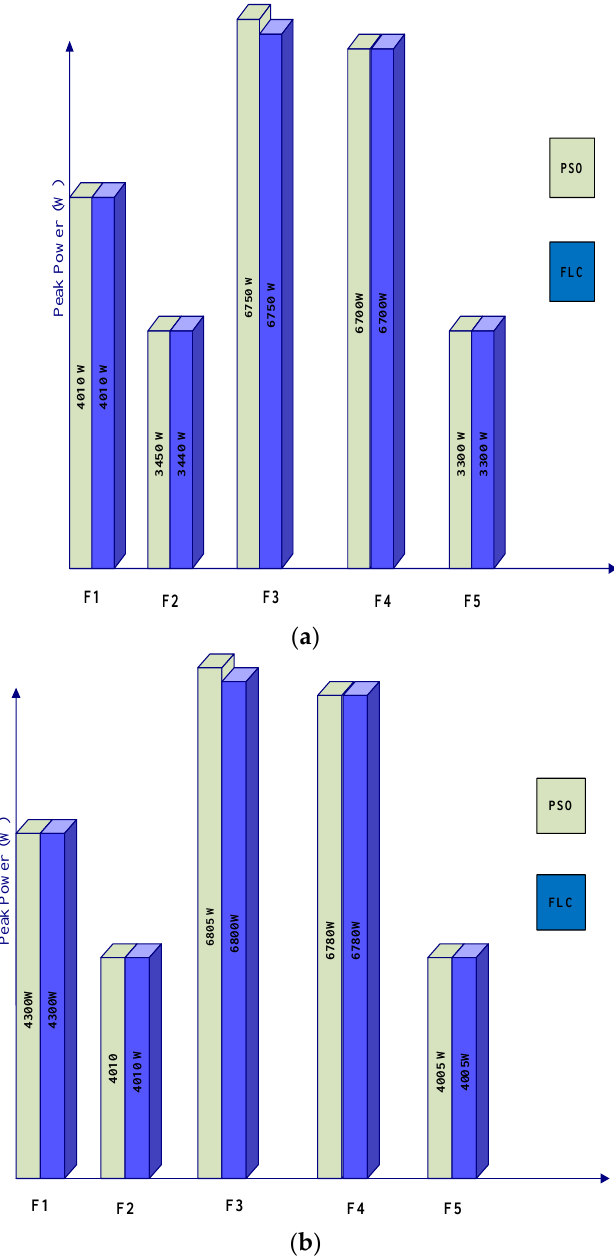
Figure 8. FL- and PSO-based controllers: ( a ) Representation of peak power generated from monocrystalline PV arrays with implementation of PSO and fuzzy logic control. ( b ) Representation of peak power generated from thin film PV arrays with implementation of PSO and FL schemes.